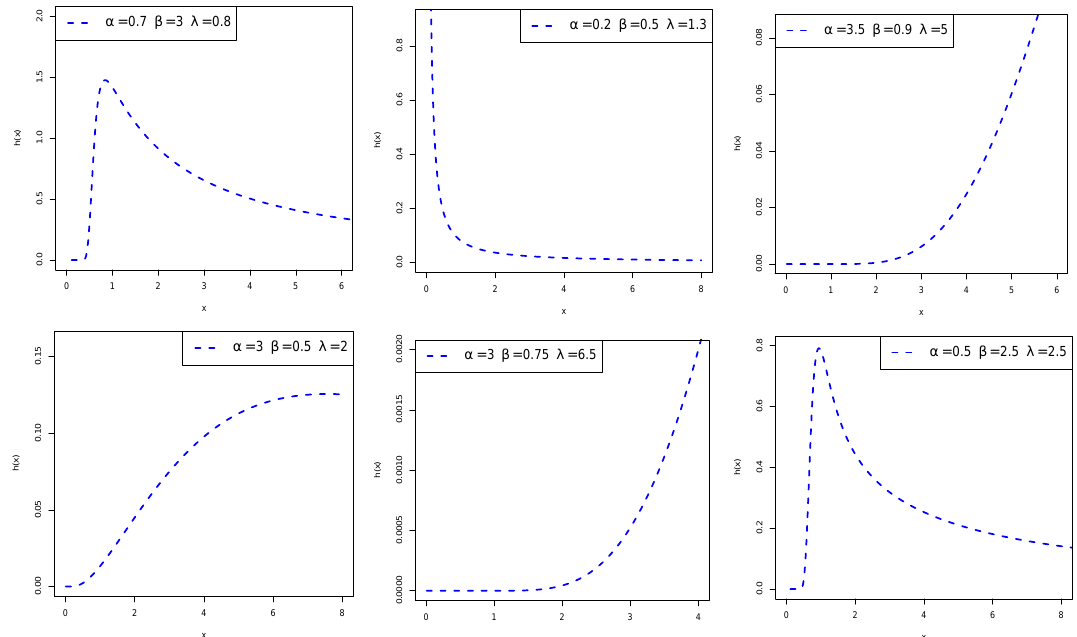
Figure 2. Plots of the IPLE hazard rate function (HRF) for different parametric